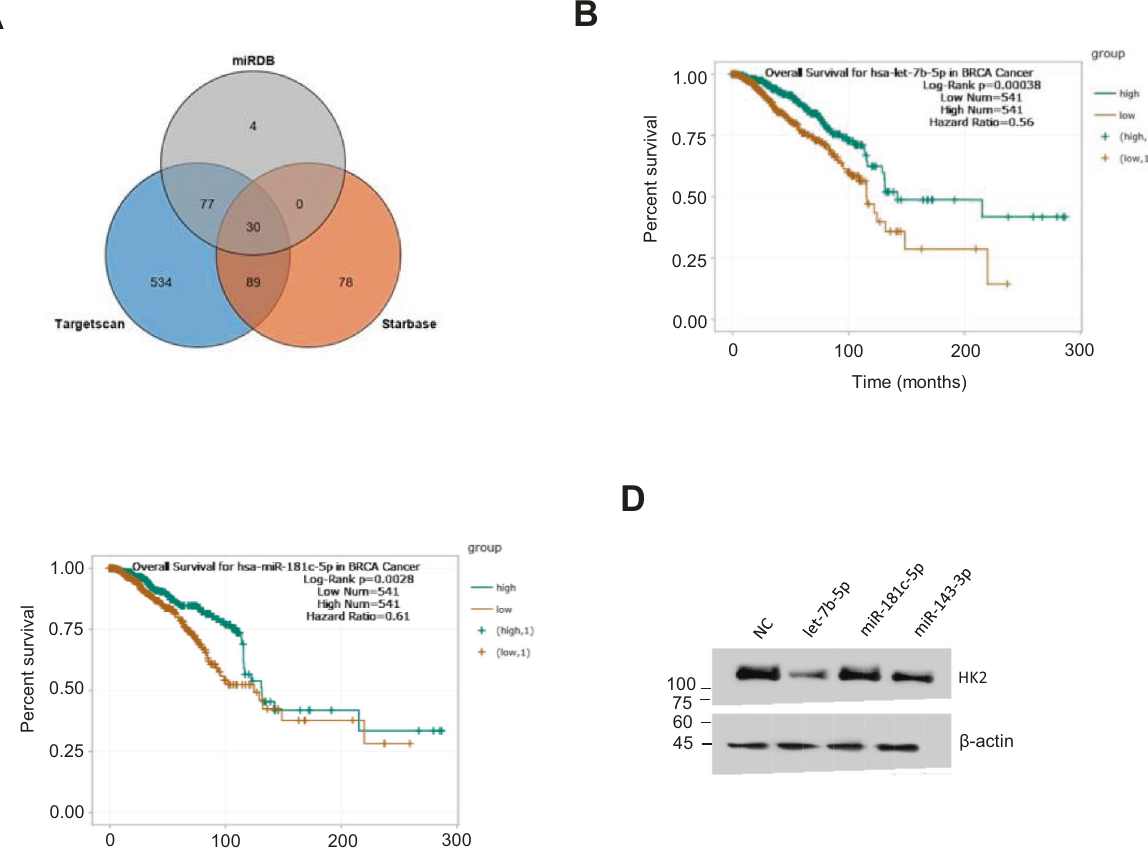
Fig. 1 Prediction of microRNAs targeting HK2 with clinical signi fi cance. A Venn diagram of microRNAs predicted to target HK2 by StarBase, miRDB, and TargetScan Databases. B , C Overall survival curves for let-7b-5p and miR-181c-5p in 541 BC patients was plotted based on the ENCORI database (https://starbase.sysu.edu.cn/). D Western blot detected HK2 expression after transfection of candidate miRNA mimics or negative control (NC) in HEK293T cells ( n = 3). miR-143-3p acted as a positive